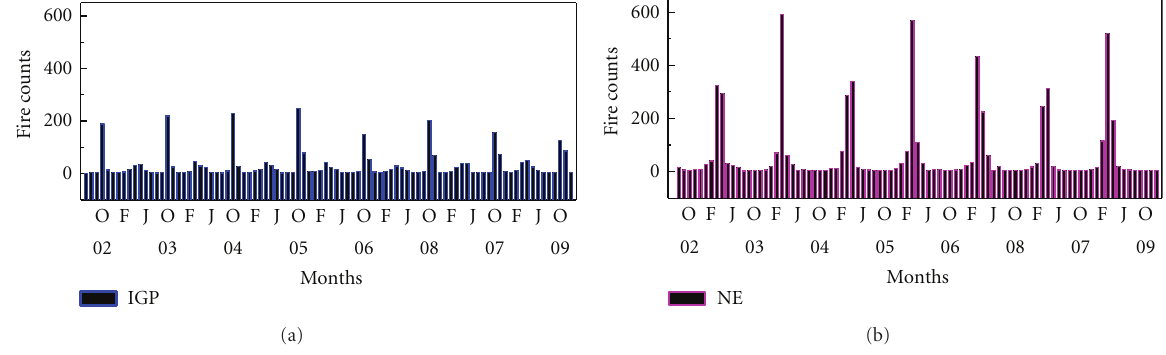
Figure 5: MODIS Aqua fire counts averaged for each month from